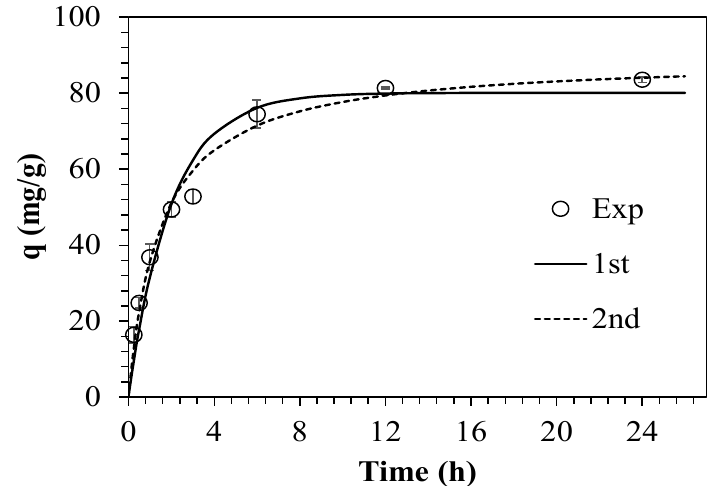
Figure 4. Pseudo-first-order and pseudo-second-order kinetic models (1st and 2nd, respectively) for adsorption of Cu(II) ions onto surface-modified polyacrylonitrile fibers. Here, q and t denote the adsorption capacity and time,